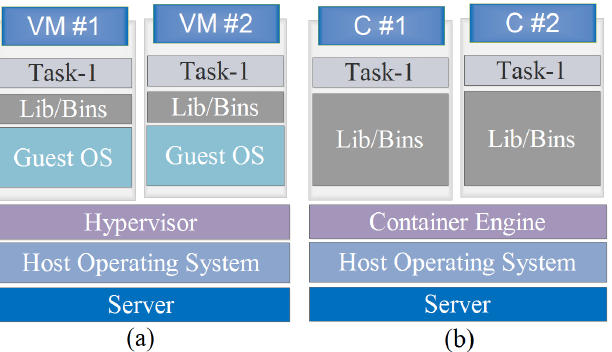
Figure 1. Virtualization Technology. ( a ) VM Architecture. ( b ) Container